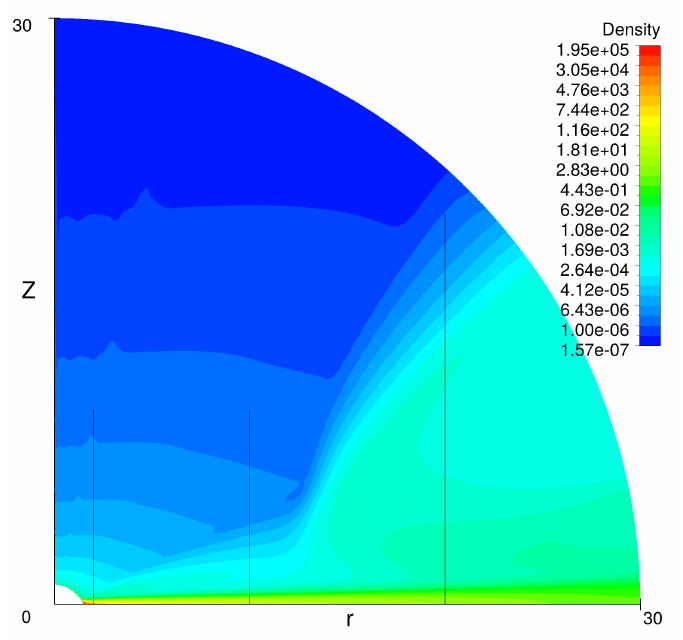
Figure 9. The density at ω =